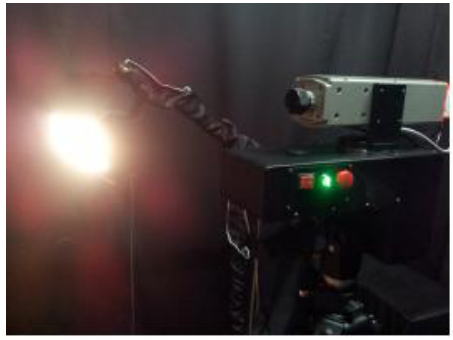
Figure 5. VNIR hyperspectral